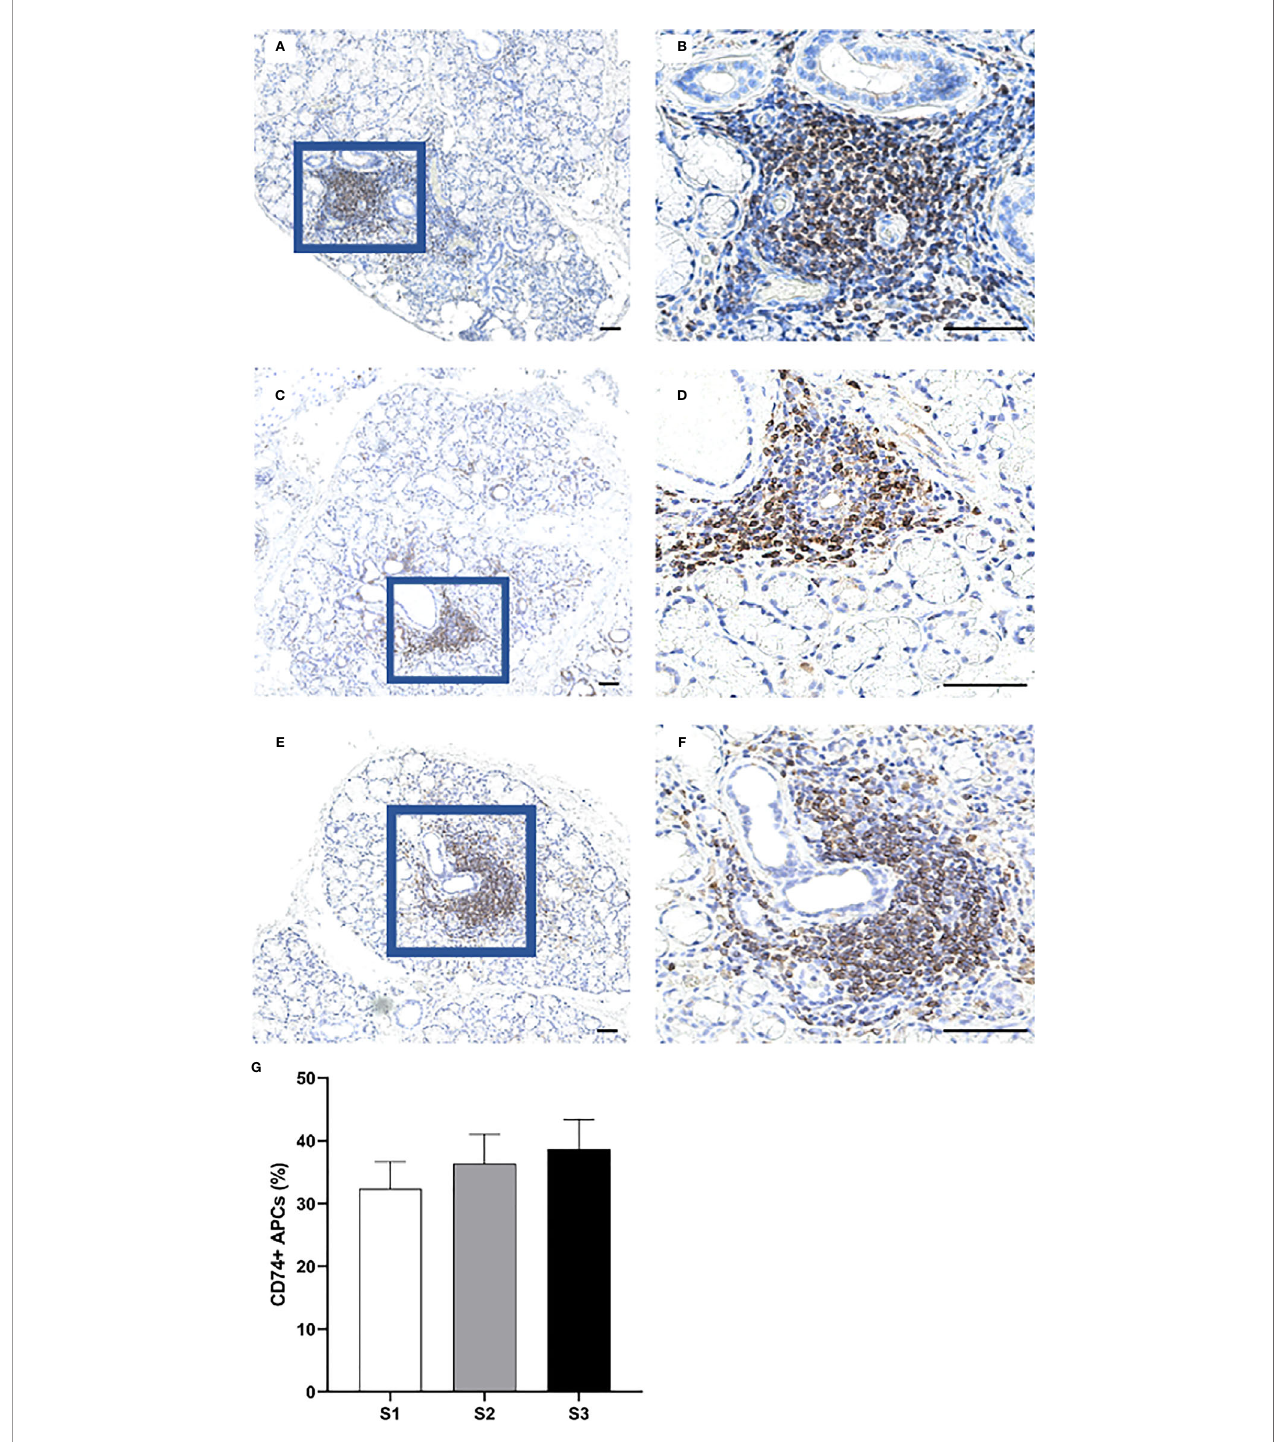
FIGURE 6 | Distribution of CD74 + cells in the MSG of patients with pSS. CD74 + APCs were found to predominantly accumulate within the in fl ammatory lesions (A – F) , and steadily increased in parallel with higher lesion severity (G) . Immunohistochemical staining displaying the distribution of a speci fi c immune cell in three representative examples of focal in fi ltrates in the MSG as classi fi ed into the respective in fl ammatory severity stages; S1 (A, B) , S2 (C, D) , and S3 (E, F) . Image (B) is a magni fi cation of (A) , image (D) is a magni fi cation of (C) , image (F) is a magni fi cation of (E) . Scale bar = 0.5 mm. Bars (G) indicate the mean percentage of cell-type number/total in fi ltrating mononuclear cells in each stage and error bars represent ± SEM. The Student's T test and Mann – Whitney U test were